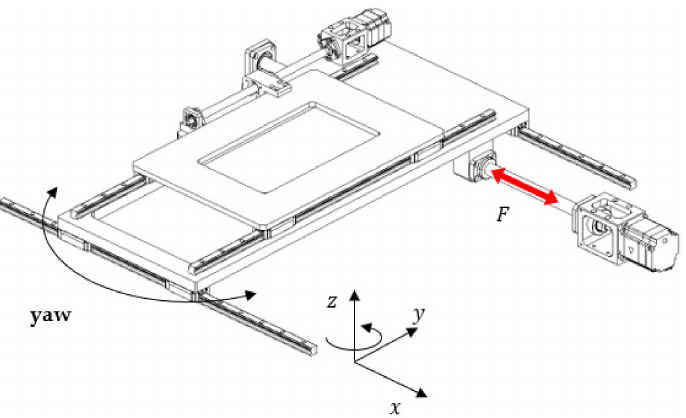
Figure 1. Scheme of offset-driven XY